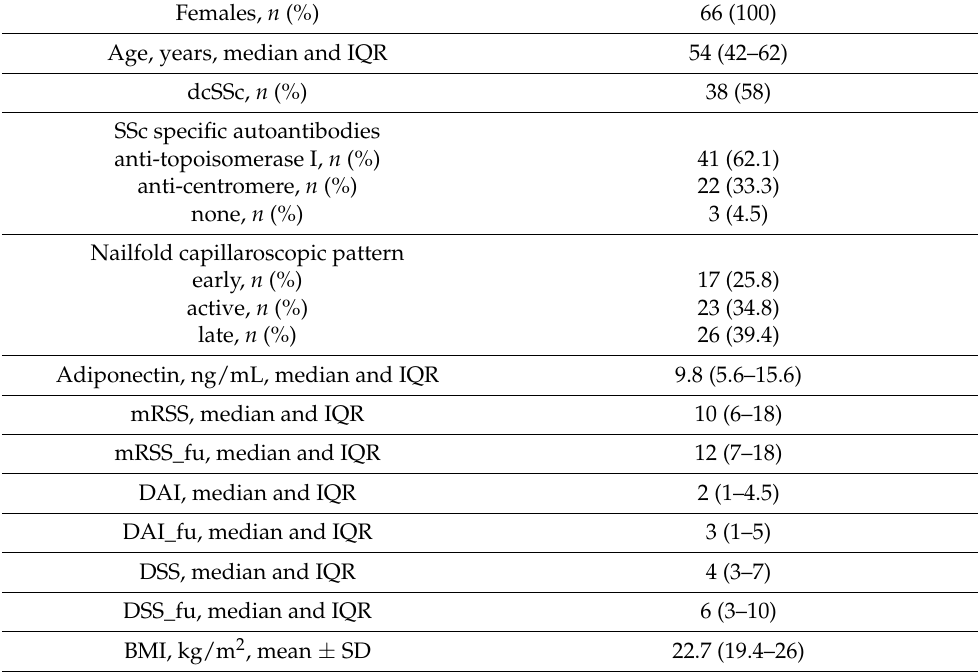
Table 1. Demographic and clinical correlates of SSc